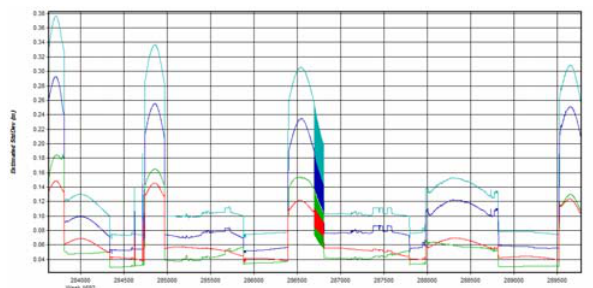
Figure 4. Combine separation of Ankara single point solution